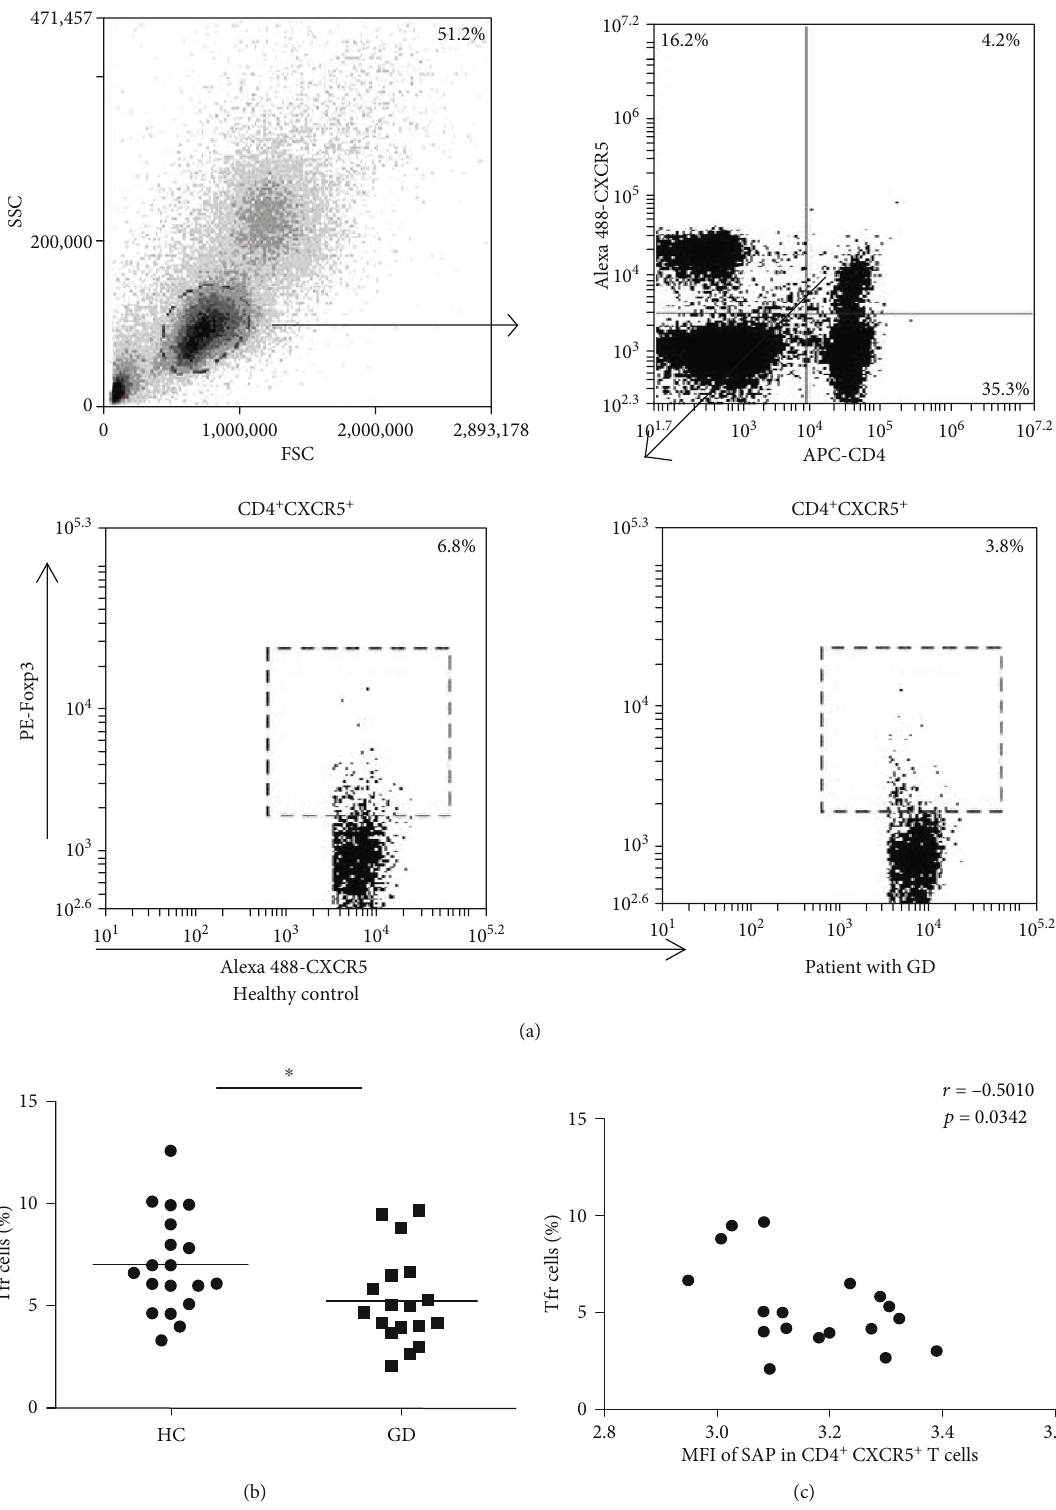
Figure 3: The percentage of Tfr cells in patients with GD. (a) Representative dot plots of CD4 + CXCR5 + Foxp3 + Tfr cells. (b) The percentage of Tfr cells from the patients with GD was lower than that in the healthy controls. (c) A negative correlation was found between the percentage of Tfr cells and the expression of SAP in CD4 + CXCR5 + T cells from the patients with GD. ∗ P < 0 : 05 , n = 18